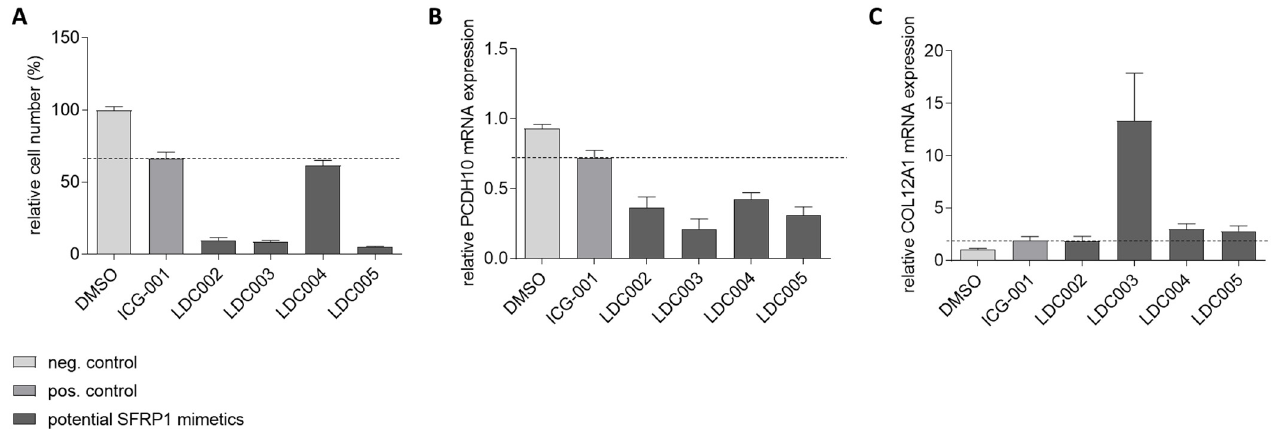
Figure 8. Secondary target gene assay in SFRP1-negative MCF7 breast cancer cells. Analysis of four LDC compounds (LDC002-005) and the reference inhibitor ICG-001 is shown as an example. ( A ) Relative cell growth in the presence of each analyzed compound is lower than for the positive control (ICG-001, dotted line). ( B ) Relative mRNA expression of PCDH10 , a gene downregulated by SFRP1, induced by the analyzed compounds is below the cut-off of the positive control (ICG-001, dotted line). ( C ) Relative mRNA expression of COL12A1 , a gene upregulated by SFRP1, induced by the analyzed compounds is at least as high or above the cut-off of the positive control (ICG-001, dotted line). Remarkably. LDC003 shows a highly significant COL12A1 -induction effect.